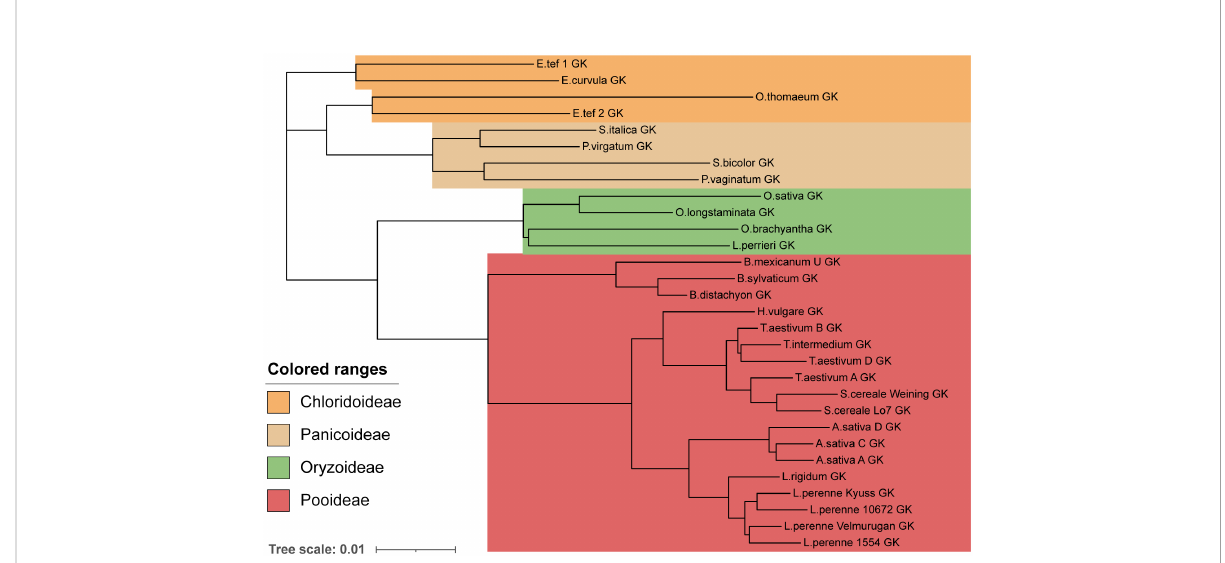
FIGURE 5 Phylogeny of grass species represented by Glycerol Kinase protein similarity. A phylogenetic tree constructed using the protein sequence of a Glycerol Kinase adjacent to all Z-loci. To produce the tree a global alignment with a BLOSUM62 cost matrix was performed, followed by tree building using a Jukes Cantor genetic distance model and nearest neighbor tree-building method. The phylogenetic tree resembles the expected relationship between species. Scale bar indicates substitutions per site.